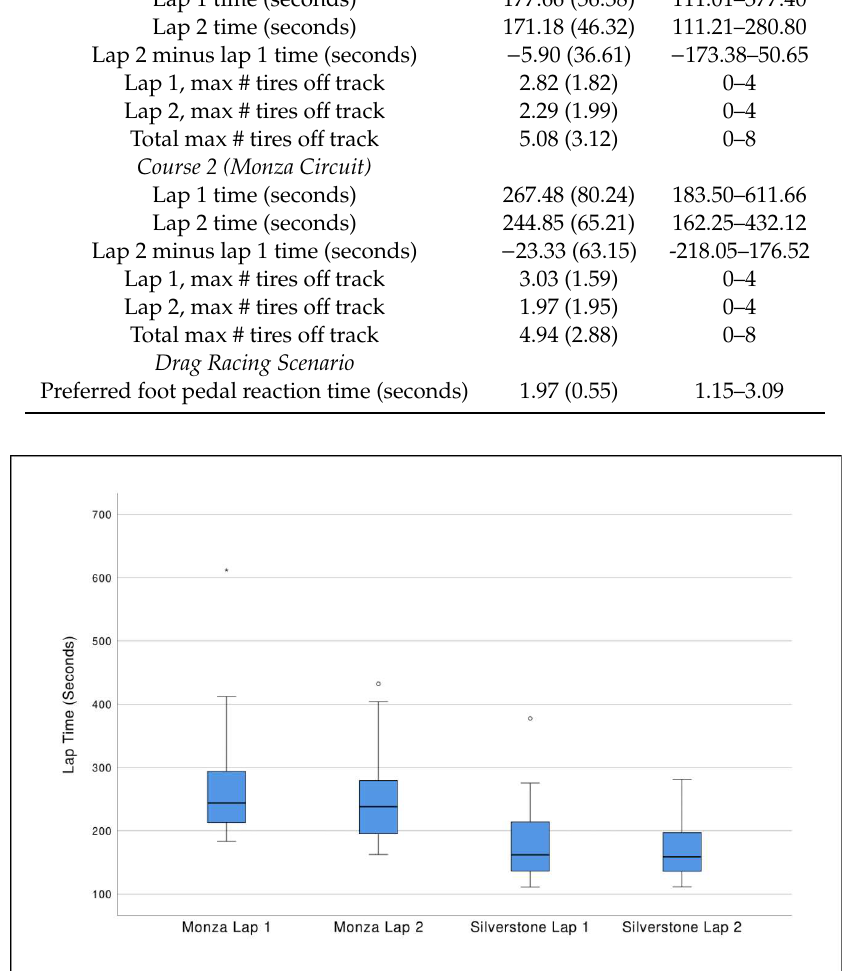
Figure 2. Boxplots showing participants racing simulator lap times (in seconds) for the Monza and Silverstone racetracks in Assetto Corsa. While participants decreased their second lap time on both courses on average, these changes did not reach statistical significance. A circle ( ) denotes an outlier (1.5 times interquartile range) and an asterisk (*) denotes an extreme outlier (3 times interquartile range).